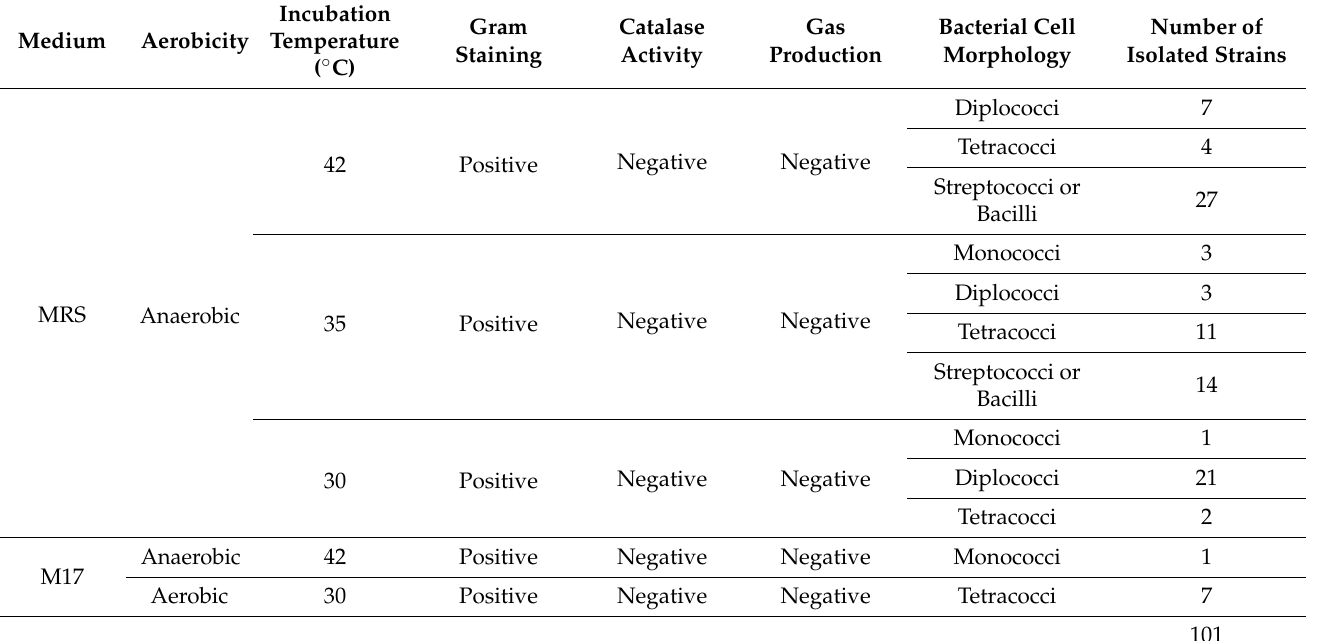
Table 1. Summary of culture conditions and general characteristics of isolated bacteria from raw goats